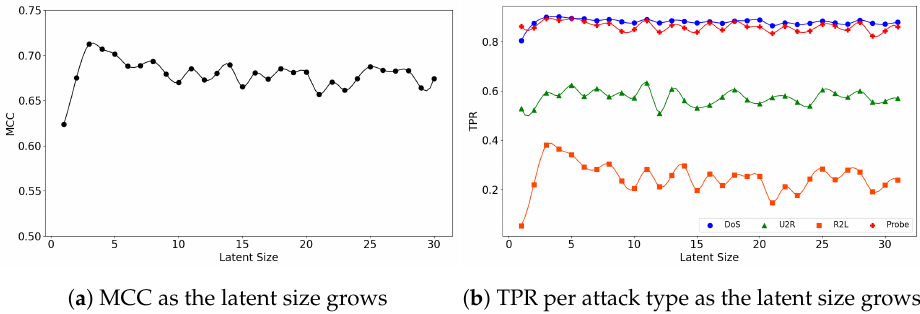
Figure 5. The results of evaluation using the NSL-KDD dataset when the (5,64) model is employed.